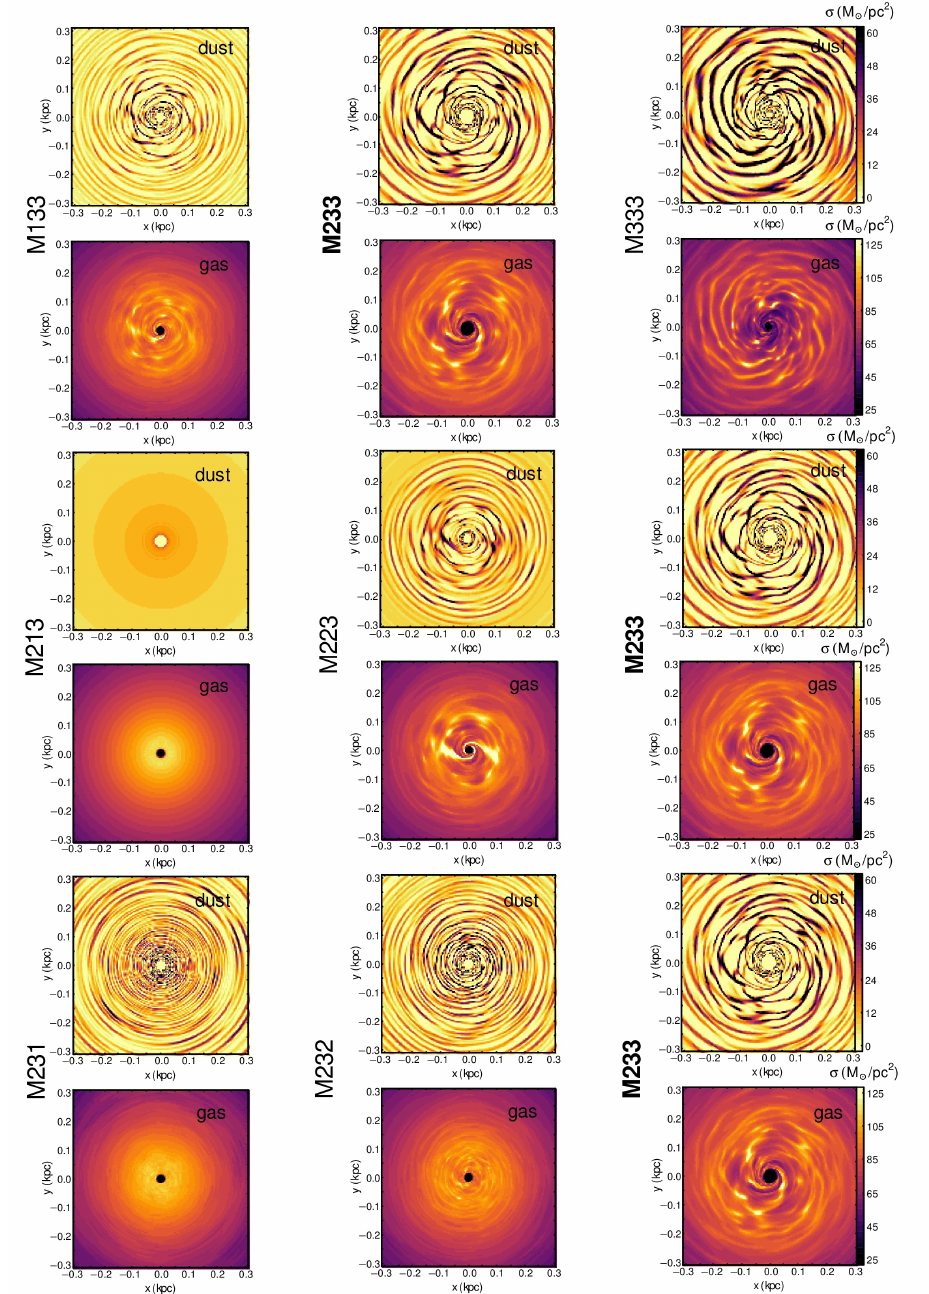
Figure 6. Distribution of dust (upper rows) and gas (lower rows) surface densities of the different models for which the parameters vary relative to the reference model M233 at time t = 1 Gyr. The color indicator with surface density (measured in [ M (cid:12) pc − 2 ]) is shown in the